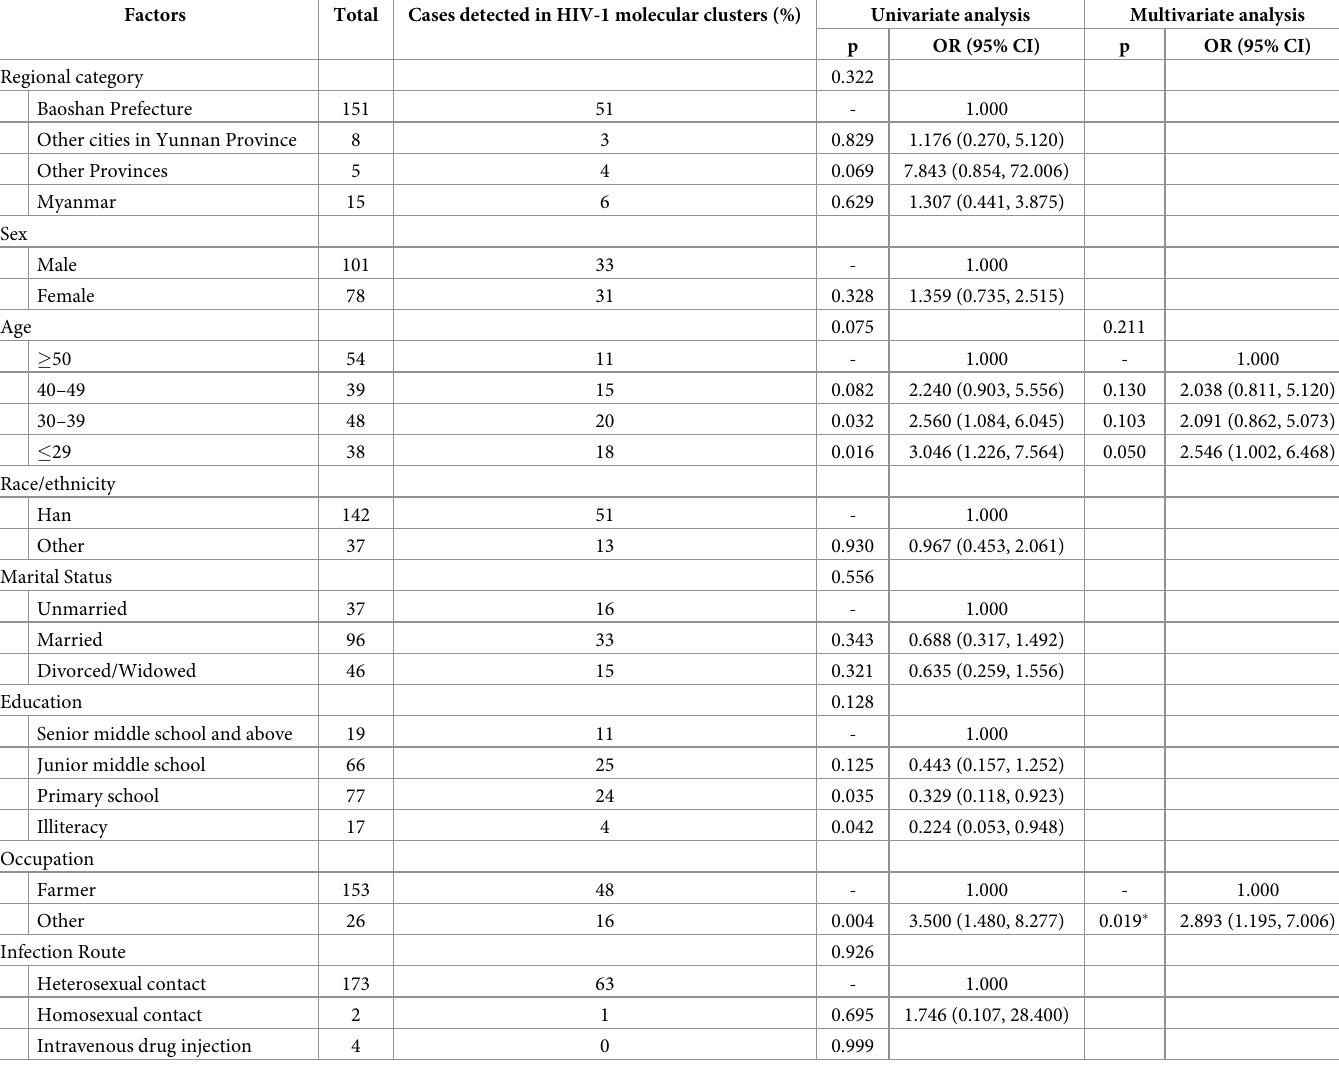
Table 3. Demographic characteristics of individuals associated recent infection events in the HIV-1 molecular